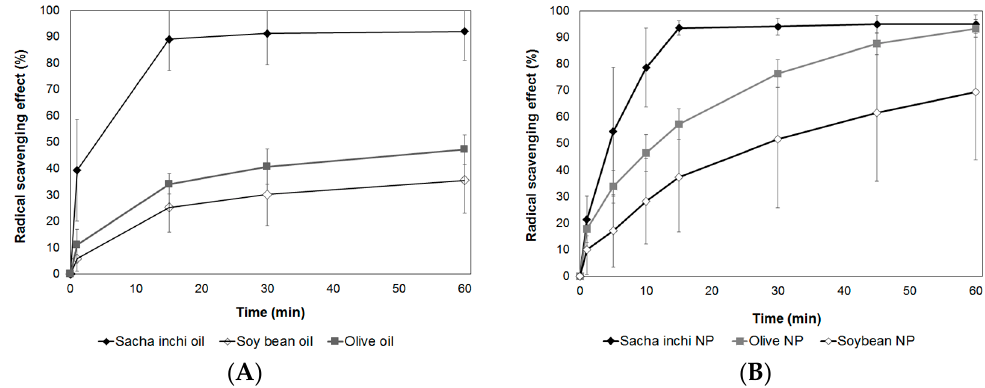
Figure 10. Evaluation of the antioxidant activity of ( A ) free vegetable oils (from sacha inchi, olive, and soybean) and ( B ) oil encapsulated in AL-CS nanoemulsions. *NP: Nanoparticles.